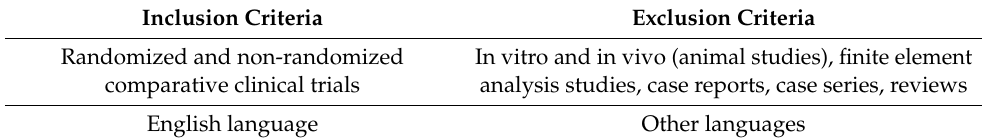
Table 2. Inclusion and Exclusion criteria.